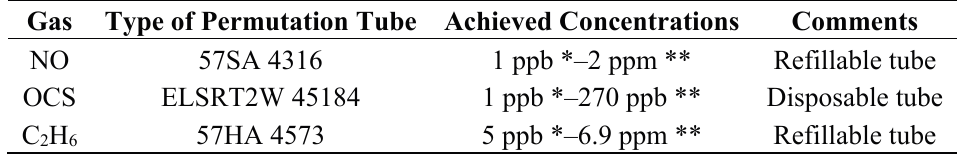
Table 3. Type of applied permeation tubes and achieved gas concentrations. Gas Type of Permutation Tube